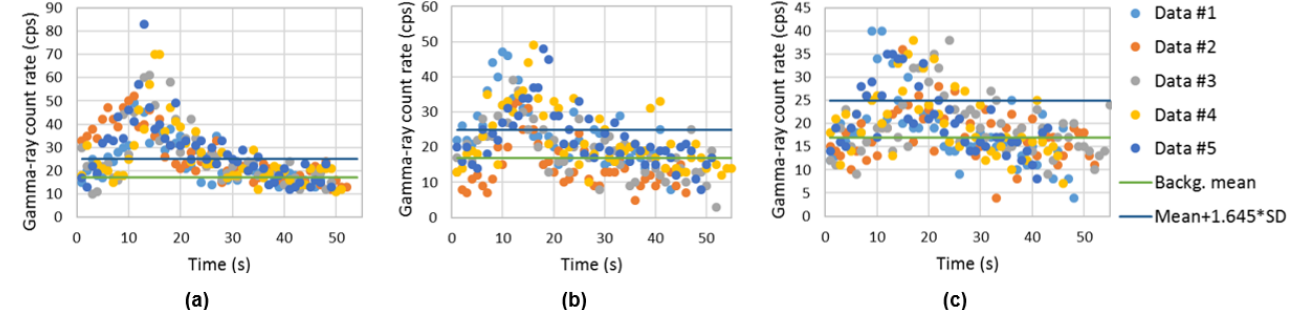
Figure 22. EJ-200 scintillator gamma-ray count rate (cps) measurements obtained using the detection system integrated in the drone considering 137 Cs sources of 4 MBq positioned at the bottom corner of the container. The distance “D” between the real sources position and the estimated position (MLE algorithm) is also given. Drone trajectories were performed at: ( a ) one-third the container height. ( b ) half the container height. ( c ) two-thirds the container height.